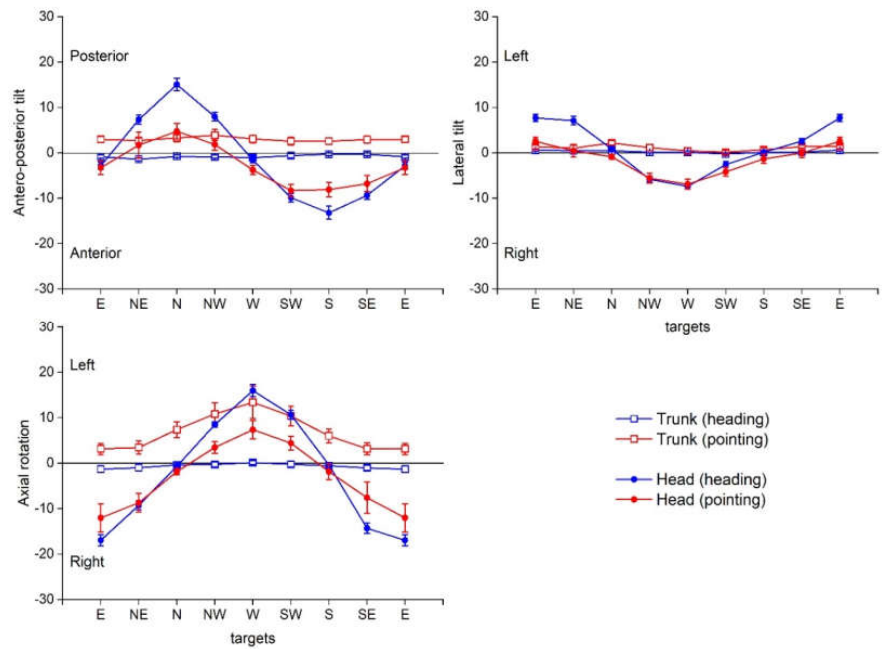
Figure 2. Variation of the head and trunk orientation in space as a function of target direction. The graphs represent the Euler angles (anterior / posterior tilt (AP), lateral tilt (LA), and axial rotation (RO)) describing the orientation of the trunk (squares) and head (circles) in space. The orientations were measured at the time of heading (blue symbols) and pointing (red symbols). Each point represents the mean ± standard error of the mean (SEM) of 10 participants.